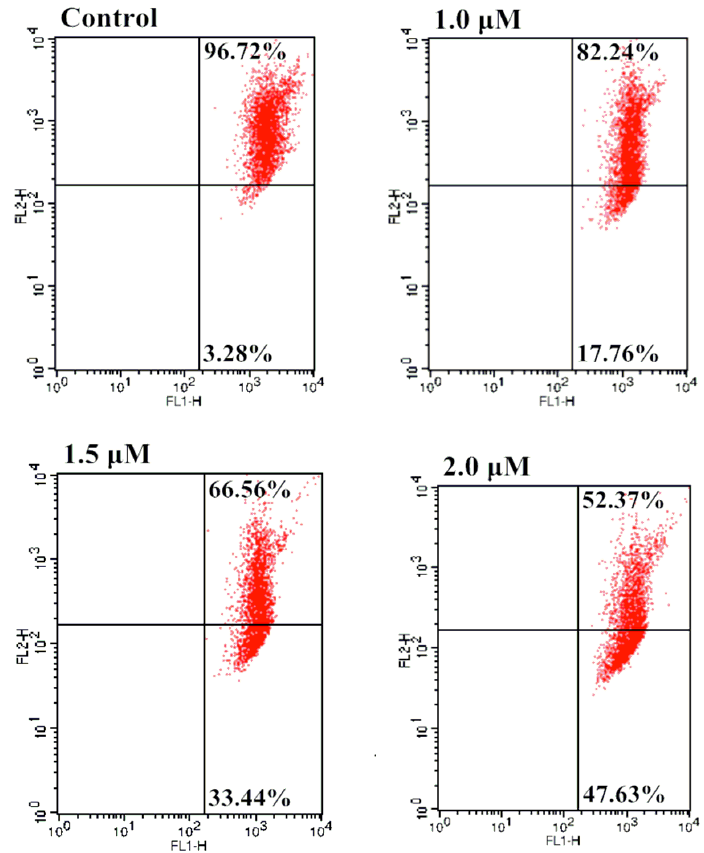
Figure 6. Effect of 10f on the mitochondrial membrane potentials of Bel-7402 cells: Bel-7402 cells were incubated with the indicated concentrations of 10f for 48 h prior to staining with JC-1.